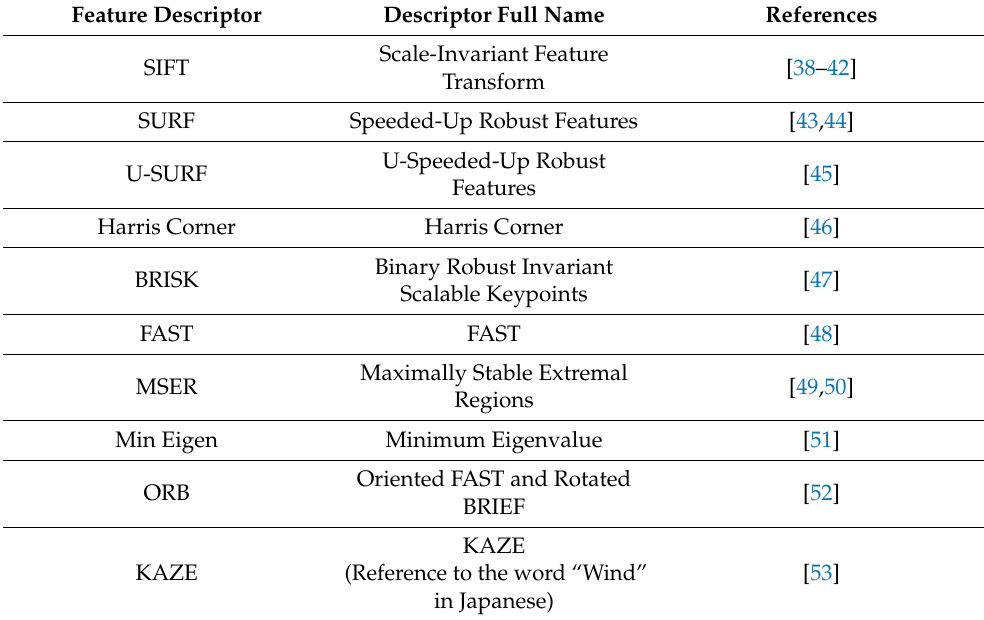
Table 1. Description of feature